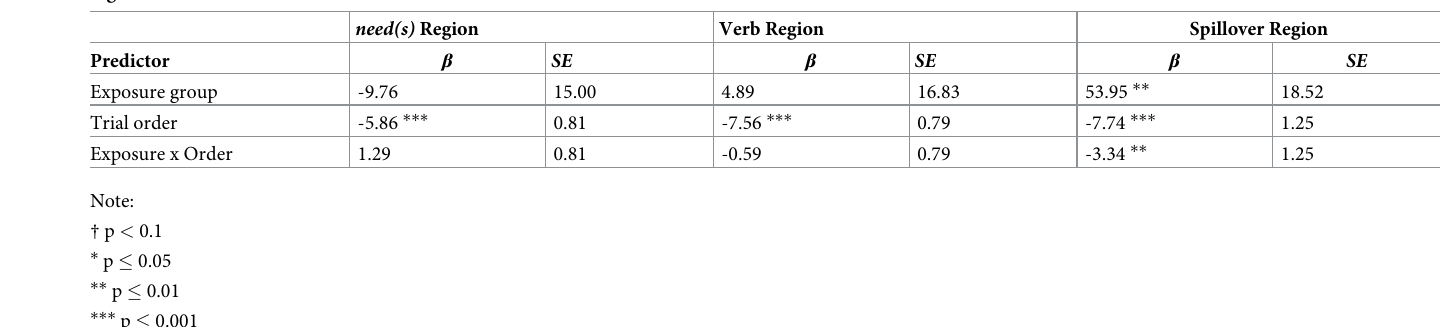
Table 6. Experiment 3 self-paced reading fixed effects summary for the three regions of analysis: The need (s) region, the critical verb region, and the spillover region.